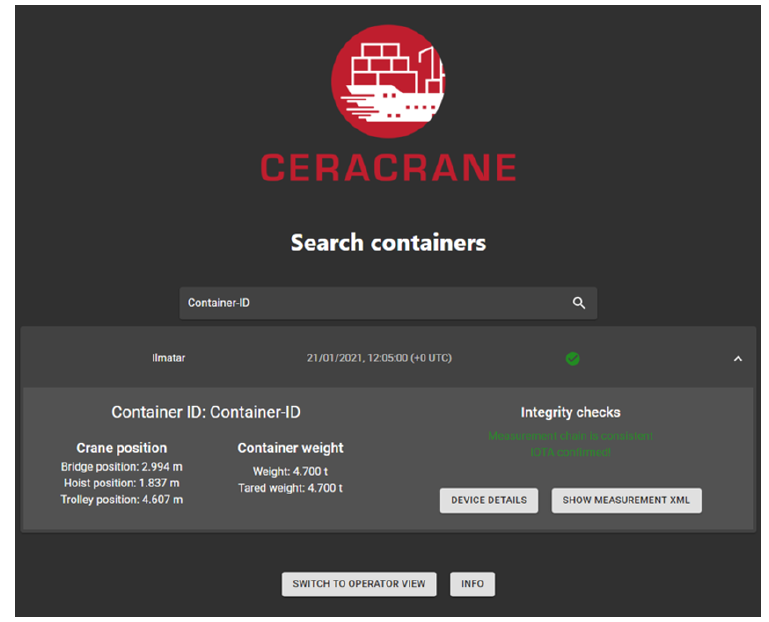
Figure 4. The search view of the UI showing a validated